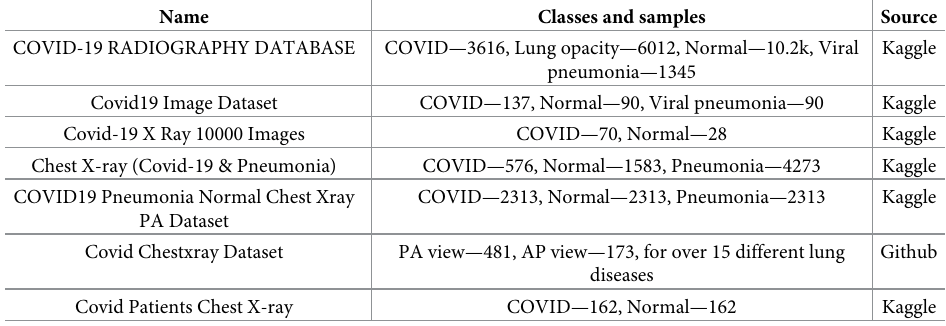
Table 1. The review of available X-ray datasets for COVID-19